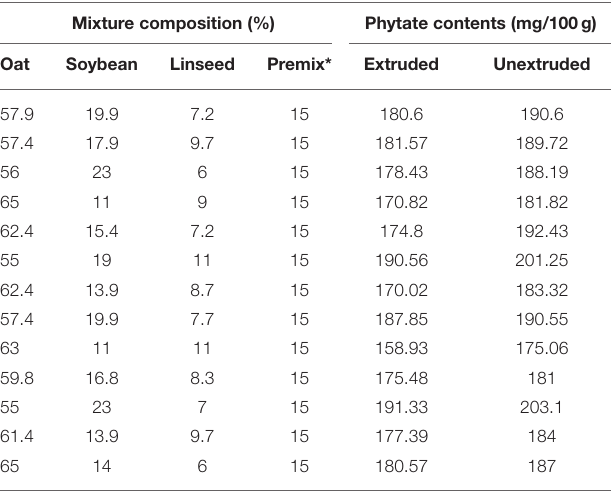
TABLE 1 | Phytate contents of the composite flour.